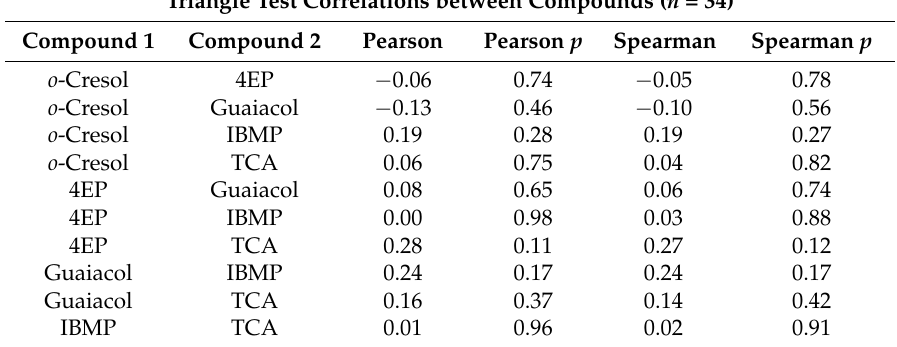
Table 2. Correlation strength between compounds according to Pearson and Spearman correlation coefficients of correct identification of spiked samples by tasters between compound pairs.